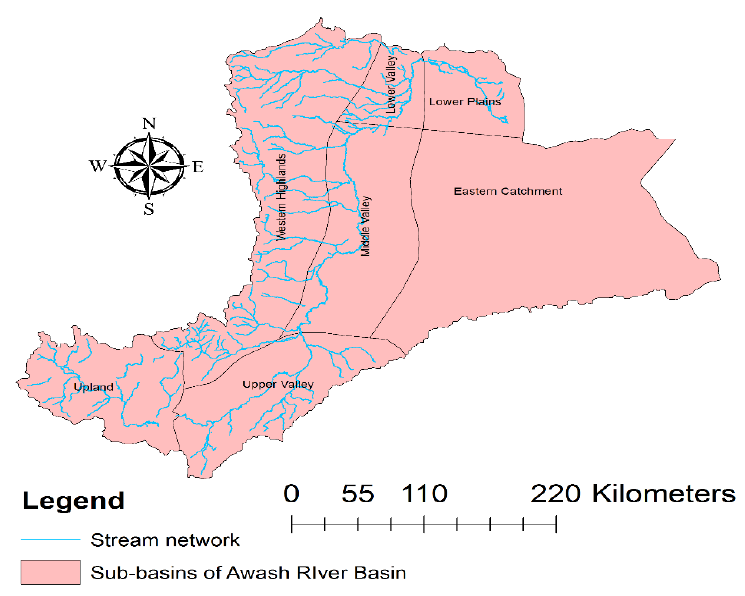
Figure 2. Sub-basins and main streams of the Awash River Basin.